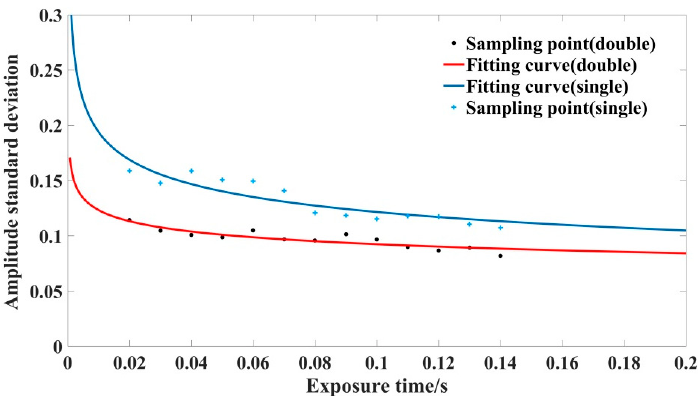
Figure 6. Comparison of fitted curves of amplitude standard deviation in single diffuser and double diffusers cases.